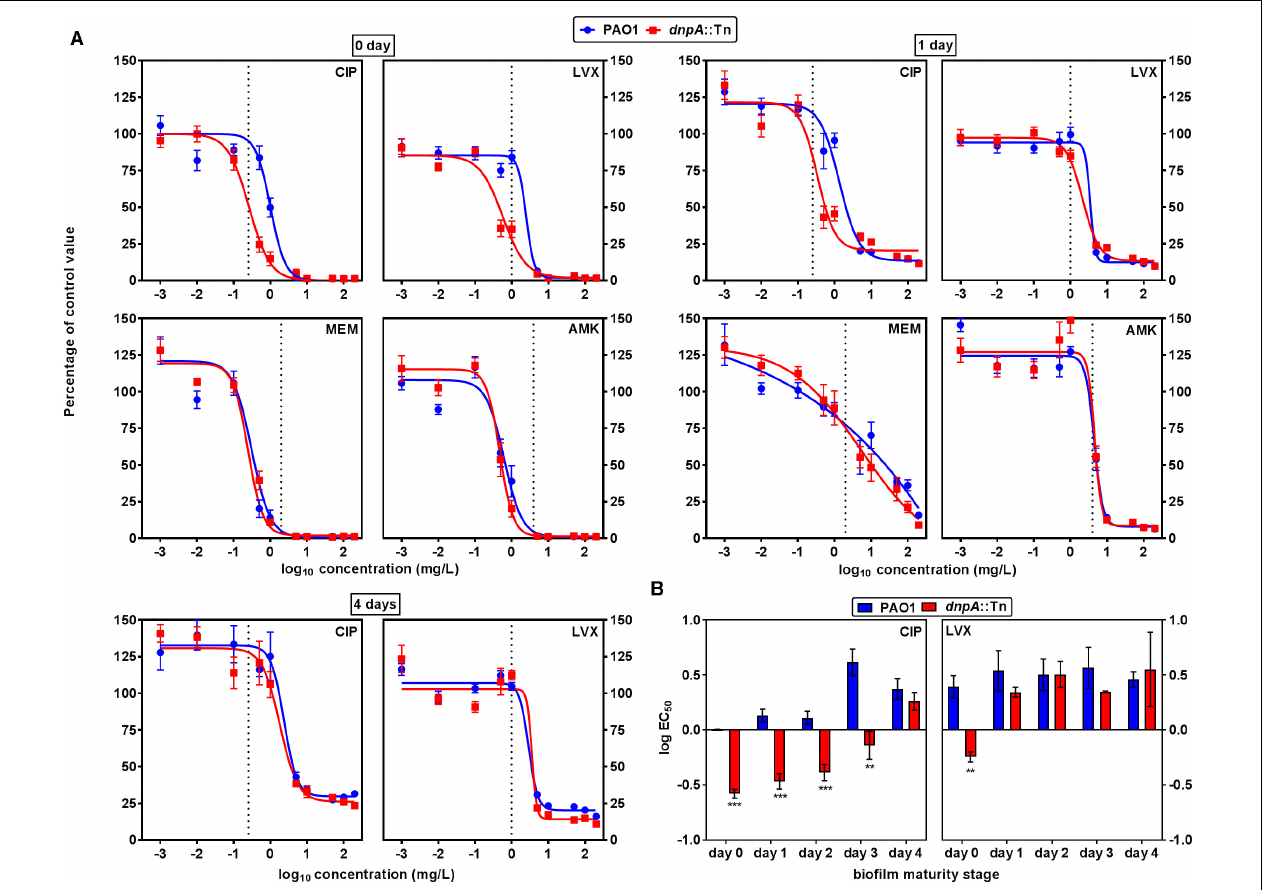
FIGURE 5 | (A) Concentration-response curves of the activity of antibiotics against cell viability in 0, 1, or 4 days-old biofilms of P. aeruginosa PAO1 (blue) or dnpA ::Tn (red). The ordinate shows the percentage of residual fluorescein fluorescence signal as compared to control biofilms. The vertical dotted line indicates MIC value in broth. CIP, ciprofloxacin; LVX, levofloxacin; MEM, meropenem; AMK, amikacin. (B) Comparison of the logEC 50 (calculated from the Hill equation of the concentration-response curve presented in (A) or of similar experiments at days 2 or 3) as a measure of the relative potency of fluoroquinolones against bacterial viability in biofilms. Values are the means ± SEM of minimum 3 experiments performed in triplicates. Statistical analysis (multiple t -test) comparing dnpA ::Tn to PAO1: ∗∗ p < 0.01 and ∗∗∗ p <